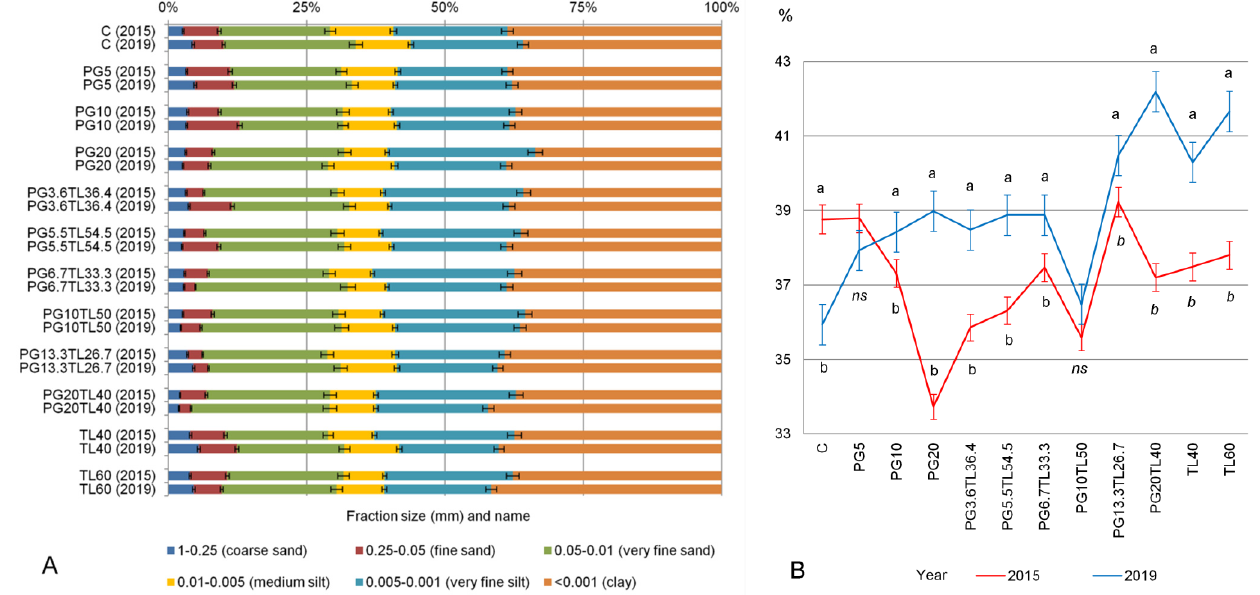
Figure 2. Effect of treatments and years on the particle size distribution ( A ) and the content (%) of clay fraction (<0.001 mm) ( B ) at the 0–20 cm soil layer. Various letters denote significant differences at p < 0.01, ns – not significant.